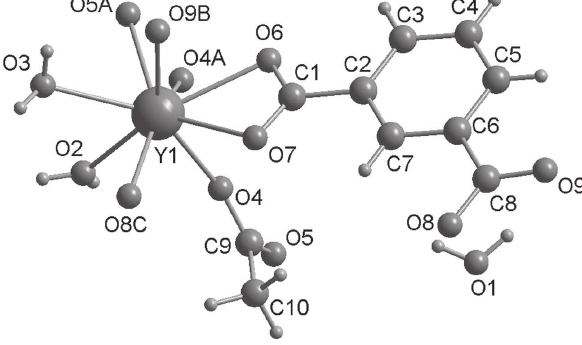
Table 1: Data collection and